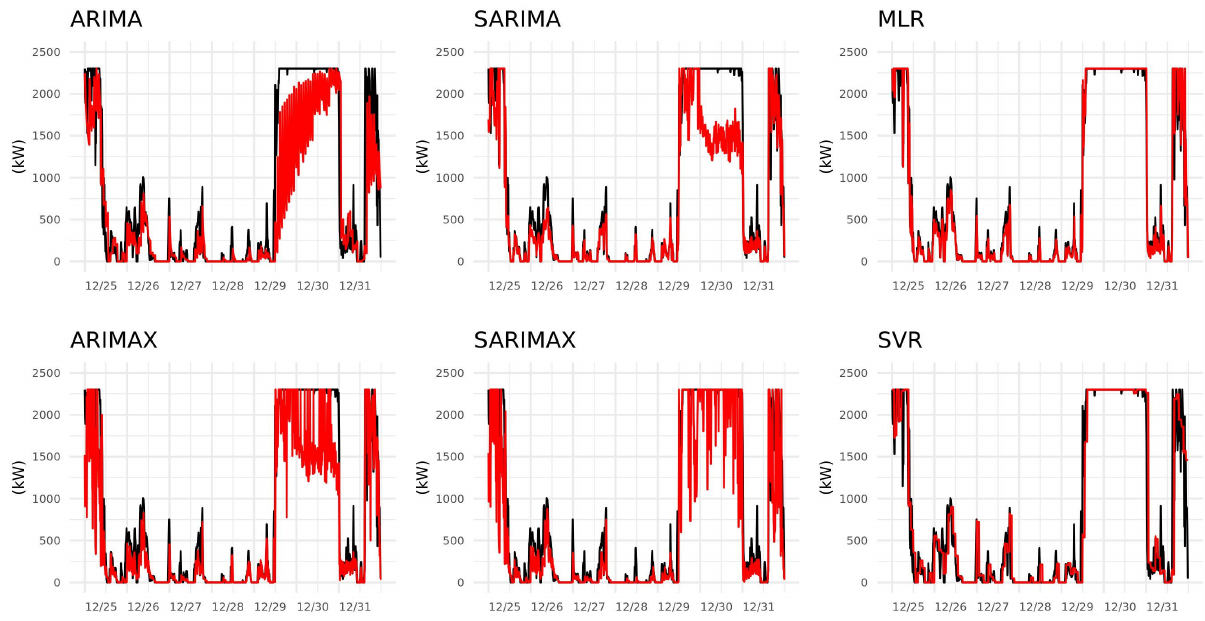
Figure 9. Actual (black) and predicted (red) value of power generation on 25 December to 31 December.